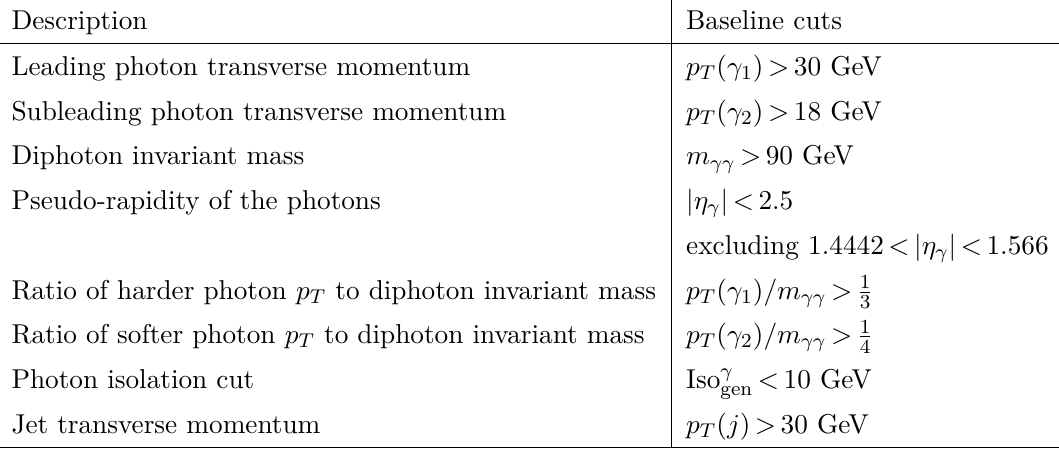
Table 2. Baseline photon and jet cuts of the 13 TeV analysis, following the CMS analysis of [31, 32]. Iso γ denotes the sum of transverse energies of stable particles in a cone of radius ∆ R = 0.3 around gen each photon.